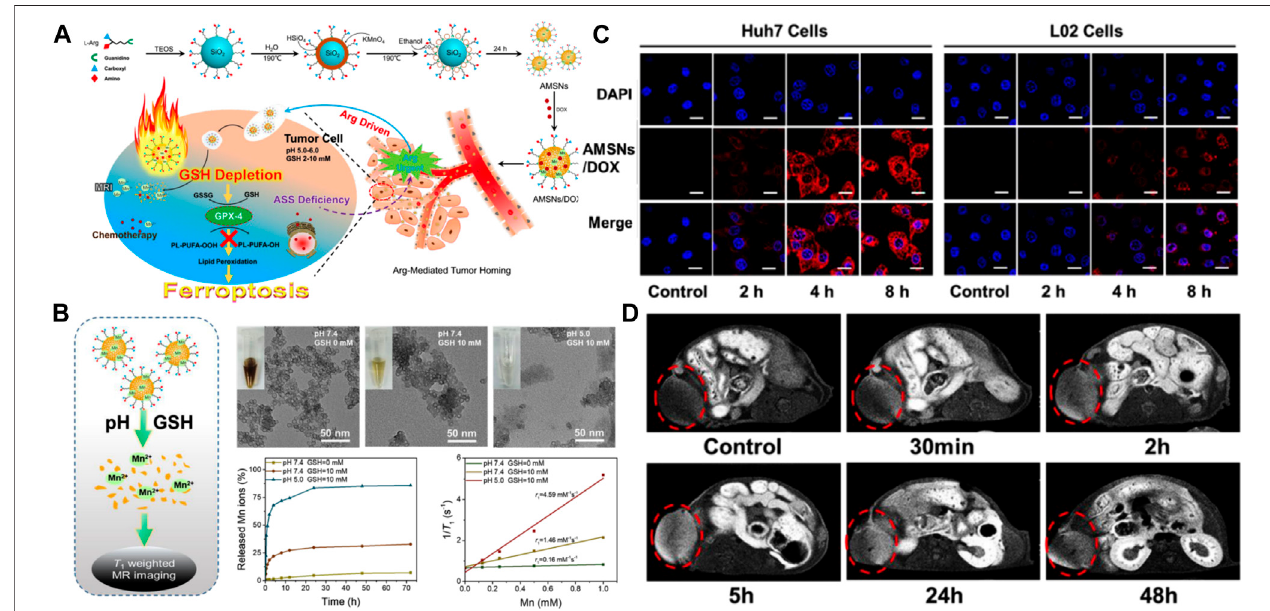
FIGURE 2 | (A) Schematic illustration of the designed synthesis of the arginine-rich manganese silicate nanobubbles (AMSNs) as well as the in vivo tumor homing afterbloodcirculation. (B) SchematicillustrationofthebiodegradationofAMSNsinlowpHandhighGSHmicroenvironmentandaccumulatedreleasepro fi lesofMnions in various pH (7.4, 5.0) and GSH concentrations (0 and 10 mM). (C) Confocal laser scanning microscope (CLSM) images of the Huh7 liver cancer cells and L02 normal liver cells after incubation with AMSNs/DOX for various periods. (D) In vivo T1-weighted MRI of tumor-bearing mice after the intravenous administration of AMSNs for different periods. Reprinted with permission from Wang et al. (2018). Copyright (2018) American Chemical